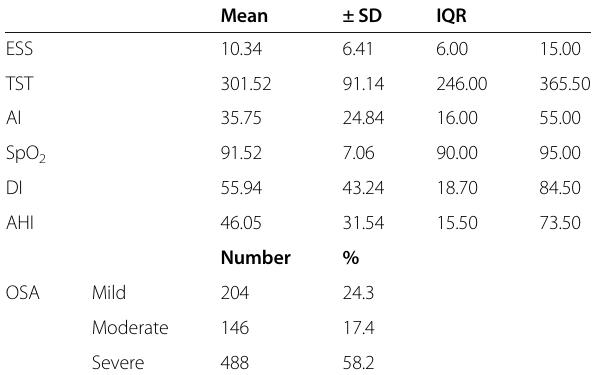
Table 2 Description of the sleep data of the patients